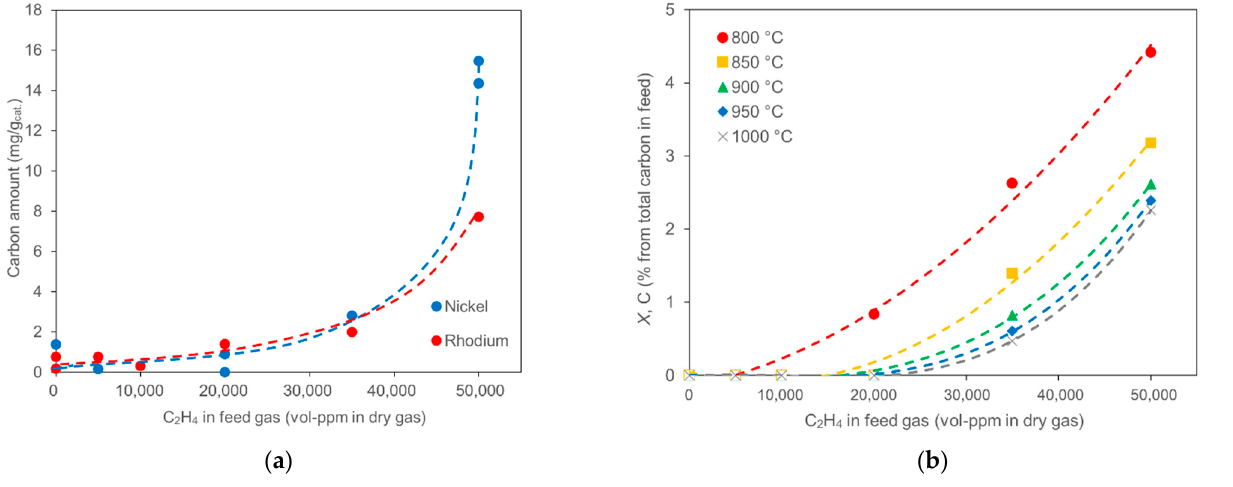
Figure 5. Effect of ethylene on carbon formation. ( a ) Carbon formation in the test runs with 0–50,000 vol-ppm of ethylene (in dry gas) with commercial nickel and rhodium catalysts. TOS 5 h. Carbon oxidized at 850 °C after the test runs. ( b ) Thermodynamic calculation by HSC Chemistry of carbon formation as a function of ethylene concentration in different reaction temperatures and atmospheric pressure.